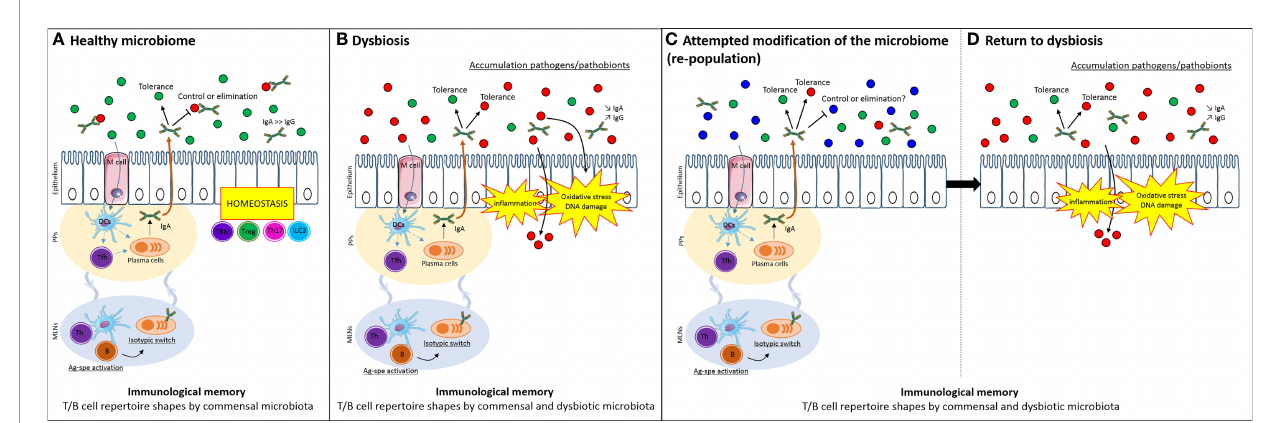
FIGURE 1 | Immunological memory selects for familiar microbiota and limits attempt to modify microbiome. (A) The host can have a balanced homeostatic relationship that inhibits (through any innate or adaptive mechanism) the growth of deleterious bacteria (in particular, those that cause acute disease, red dots) while co-existing with symbiotic species (green dot) or even species that pose no immediate risk but may contribute in the future to chronic disease such as IBD or CRC (e.g. a pathobiont, red dots). Antigen-speci fi c activation of T and B cells imparts the immunological memory to the existing microbiome. (B) In dysbiosis, microbes favoring in fl ammatory responses and carcinogenesis exist in the presence of host responses that are also antigen-speci fi c. These responses have adapted to favor the persistence of the dysbiotic microbial population. (C) When attempts are made to modulate the microbiota – without altering the immunological memory - existing host responses from the dysbiotic state persist and (D) favor the re-selection of the same community, provided through the therapeutic inoculum (such as a fecal transplant) or additional encounters in the host ’ s normal environment, e.g. microbes shared from family members, dietary ingredients and so on. DCs, dendritic cells; Tfh, follicular T cells; Th, helper T cells; T RM , tissue-resident memory T cells; Treg, regulatory T cells; B, B cells; IgA, immunoglobulin A; IgG, immunoglobulin G; Ag-spe activation, antigen-speci fi c activation; PPs, Peyer ’ s patches; MLNs, mesenteric lymph